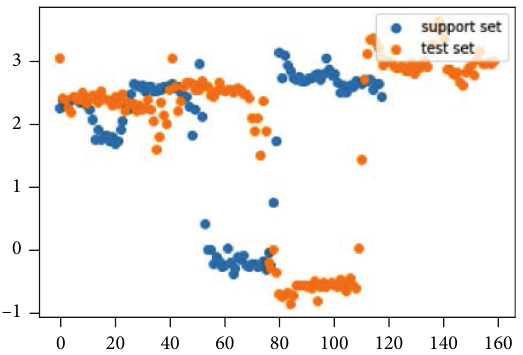
Figure 5: Example of gesture feature